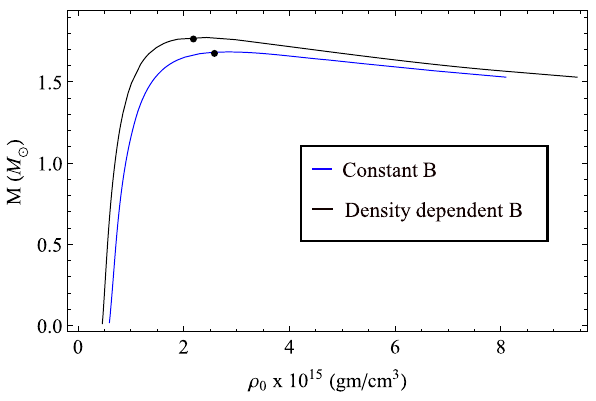
Fig. 27 Variation of mass ( M ) of compact objects with central den- sity ( ρ 0 ) for B surface = 82 . 11 MeV/fm 3 defined at the surface where radial pressure vanishes. Here we consider two different cases (i) at first case we take B as constant and (ii) a density dependence of B is considered in accordance with Eq. (53) where the coefficients k i are k 0 = 56 . 4636, k 1 = 0 . 02846, k 2 = 0 . 000217, k 3 = − 2 . 548 × 10 − 7 , k 4 = 1 . 892 × 10 − 10 and k 5 = − 6 . 192 × 10 − 14 . The maximum mass points are indicated with small filled